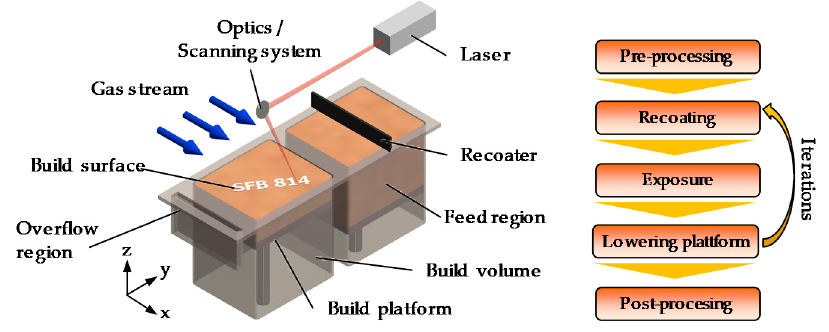
Figure 1. Left: Schematic drawing of a PBF-LB/M machine. Right: Build cycle.